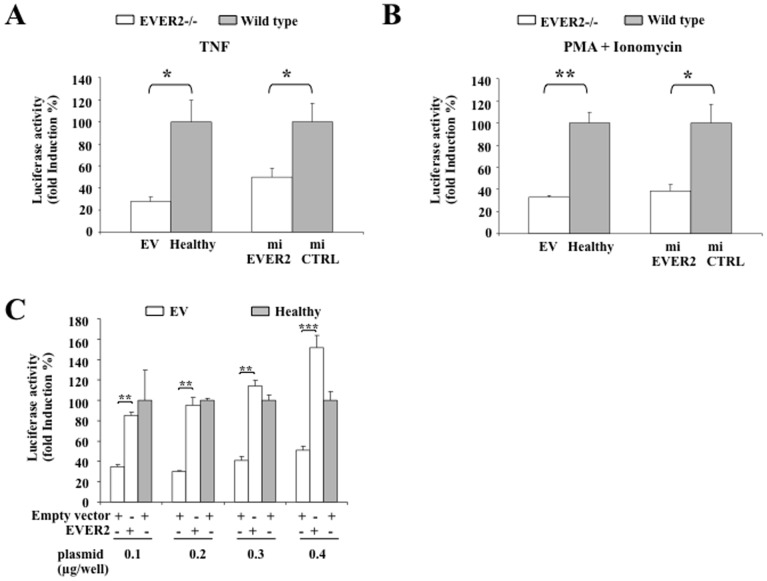
EVER2 regulates the transcriptional activity of NF-κB.(A–B) Keratinocyte cell lines were transiently transfected with 0.3 µg/well NF-κB luciferase reporter. The cells were serum-starved overnight and left untreated or were stimulated with TNF (A) or a combination of PMA+ionomycin (B). The cells were harvested and assayed for luciferase activity. The data shown are expressed as fold-induction with respect to nonstimulated cells. Values obtained with wild type cells were taken as 100%. The data shown are means ± SD of three independent experiments. (C) EV or healthy cells were transiently transfected with the NF-κB/luc construct (0.3 µg/well) and various amounts of a plasmid encoding EVER2 or an empty vector as a control. Cells were assayed for luciferase activity after stimulation with TNF following serum starvation. The data shown are expressed as fold-induction with respect to nonstimulated cells. Values obtained with healthy cells transfected with empty vector were taken as 100%. The data shown are means ± SD of three independent experiments. *, P<0.05; **, P<0.01; ***, P<0.001.